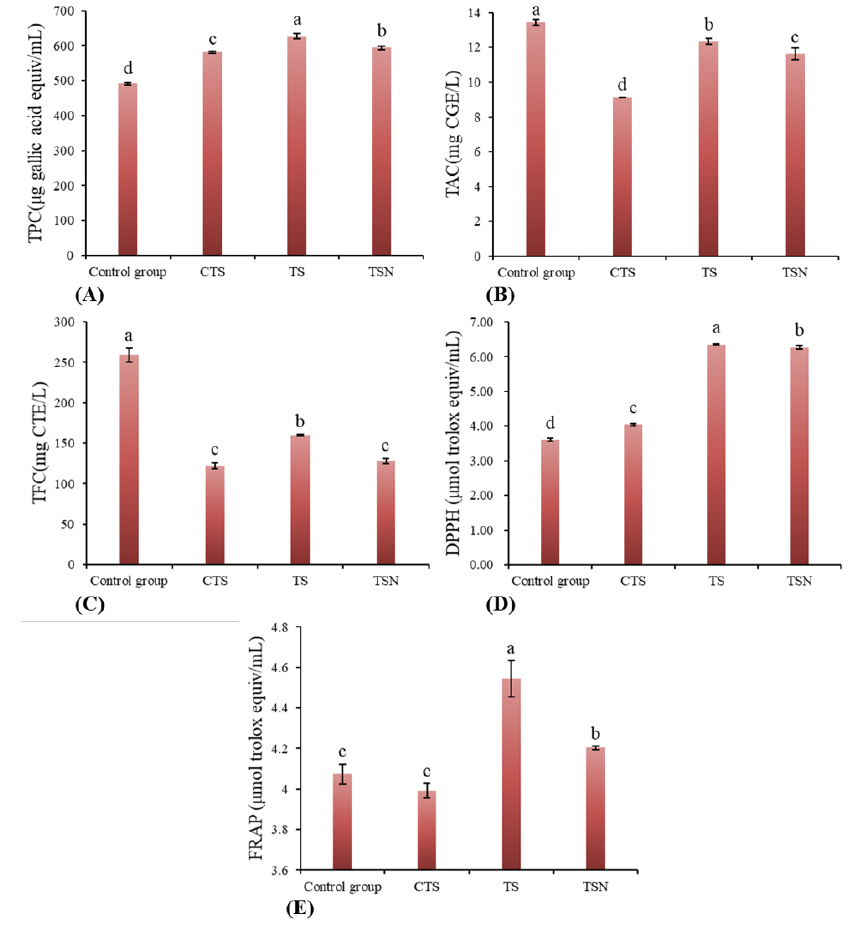
Figure 5. E ff ects of di ff erent sterilization treatments on the functional indicators of grape juice. ( A ) Total polyphenol content (TPC); ( B ) Total Anthocyanin Content (TAC); ( C ) Total Flavonoid Content (TFC); ( D ) DPPH scavenging activity; and ( E ) FRAP